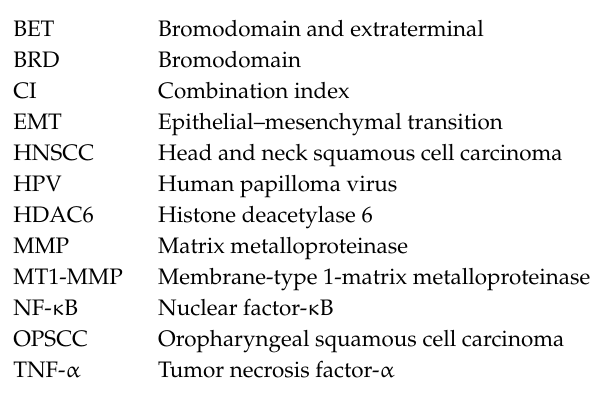
Supplementary Figure S4: Gene expression analysis of HDAC6, BRD2, and BRD4. (A–C) Relative gene expression level of HDAC6, BRD2, and BRD4 in normal and HNSCC patient samples. ** p < 0.01 vs. normal samples. (D–F) Relative gene expression level of HDAC6, BRD2, and BRD4 in HPV-positive and HPV-negative HNSCC samples. expression and its association with HDAC6 mRNA in HNSCC patient samples based on Pearson’s correlation. (H) correlation. (I) BRD2 mRNA expression and its association with HDAC6 in HPV-negative HNSCC samples based on Pearson’s correlation. Genomic array data of BRD2 and HDAC6 were obtained from NCBI GEO under for HPV-positive HNSCC, n = 28 for HPV-negative HNSCC). Gene expression profiles were compared